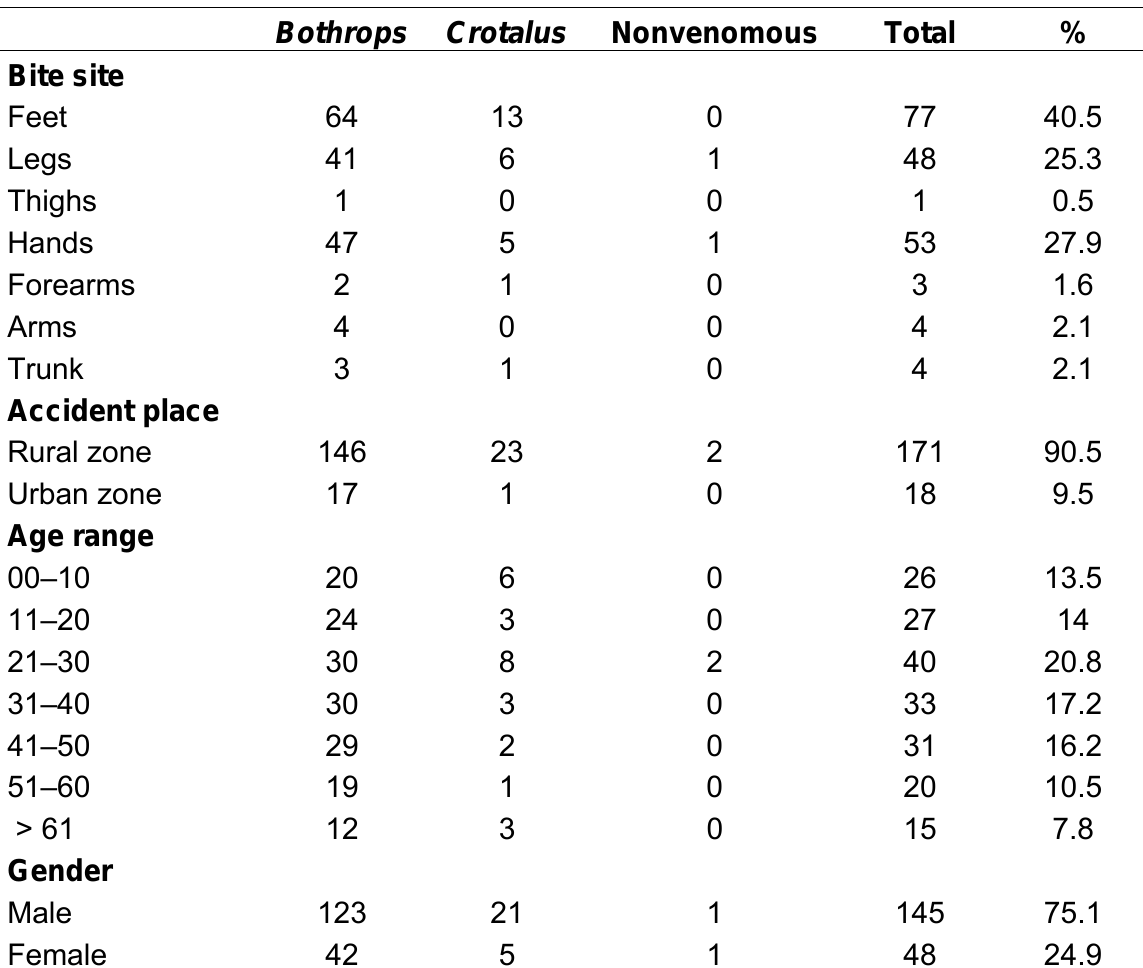
Table 2. Frequency of snakebites recorded by the Southwest II Regional Health Bureau, Goiás State, Brazil, between January 2002 and December 2005, according to the patient’s age and gender, the bite site, and the accident